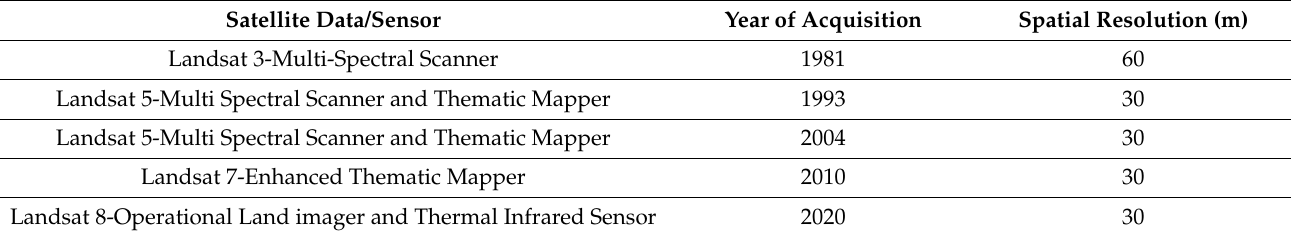
Table 1. Specifications of the satellite Table 1. Speci fi cations of the satellite data.